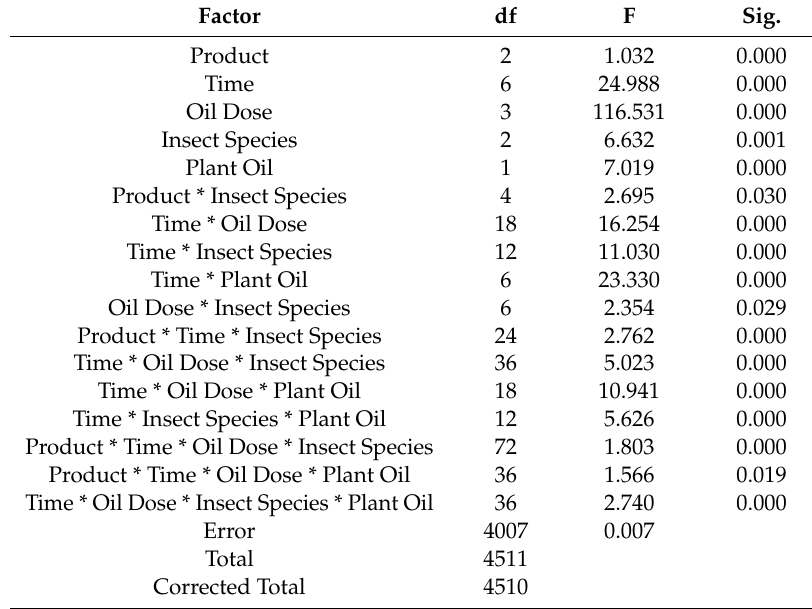
Table 1. ANOVA parameters for main e ff ects and associated interactions between Product, Hours, Dose, Insect larvae and Treatment, over the Dependent Variable of Mortality. Non-significant interactions have been omitted for